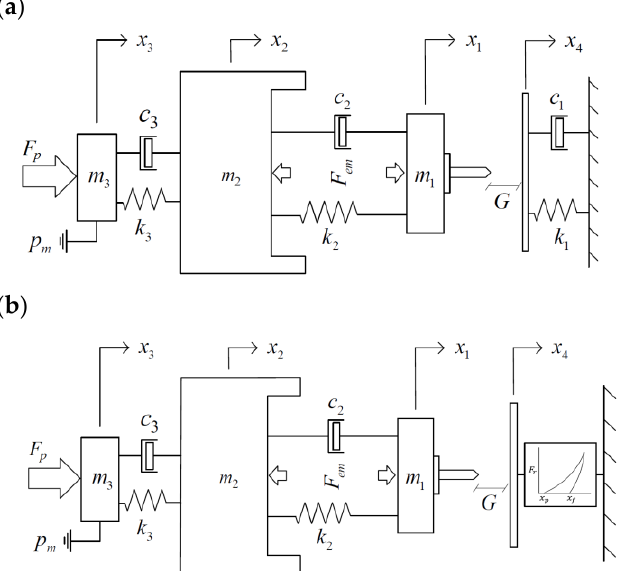
Figure 2. Physical system in Figure 1 involving ( a ) a metal sample and ( b ) a sandstone sample. For both samples, static force F p is exerted by air on the piston-head mass m 3 in the pneumatic cylinder, and its motion is opposed by a friction force p m ; the connection between m 3 and electrodynamic shaker body m 2 is modelled by spring k 3 and damper c 3 , while the connection between m 2 and armature mass m 1 is modelled by spring k 2 and damper c 2 , and both are in parallel configuration; m 1 is excited by an electromagnetic force, F em of amplitude F a and frequency f . When gap G is closed, the resistive force exerted by the metal sample on m 1 is contributed to by spring k 1 and damper c 1 in parallel configuration, while the resistive force exerted by the sandstone sample on m 1 is as stated in Equation